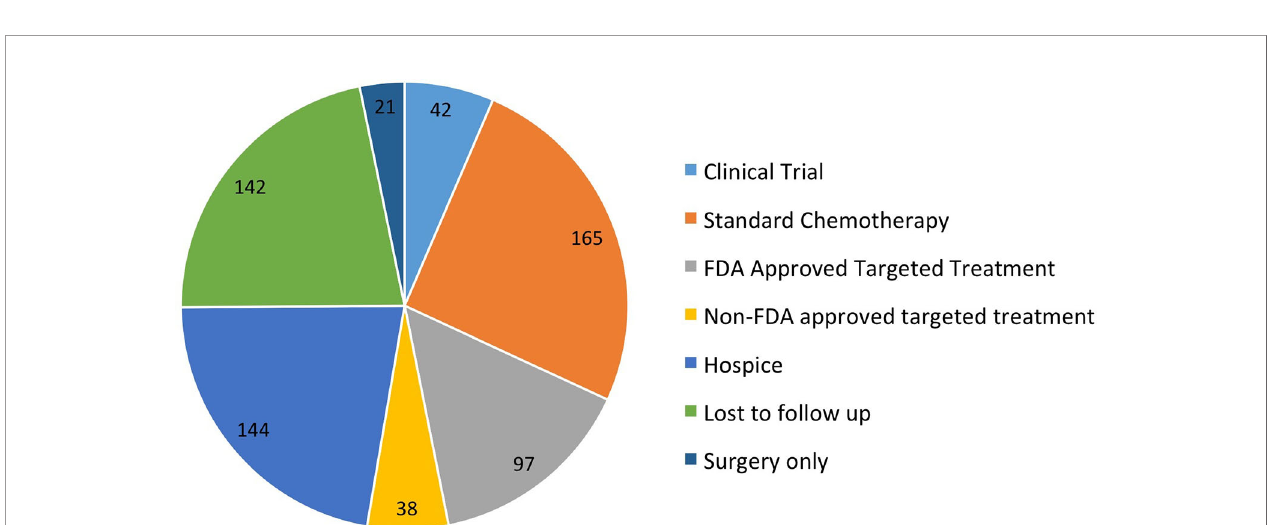
FIGURE 1 | Treatment received after results of F1CDx testing available.